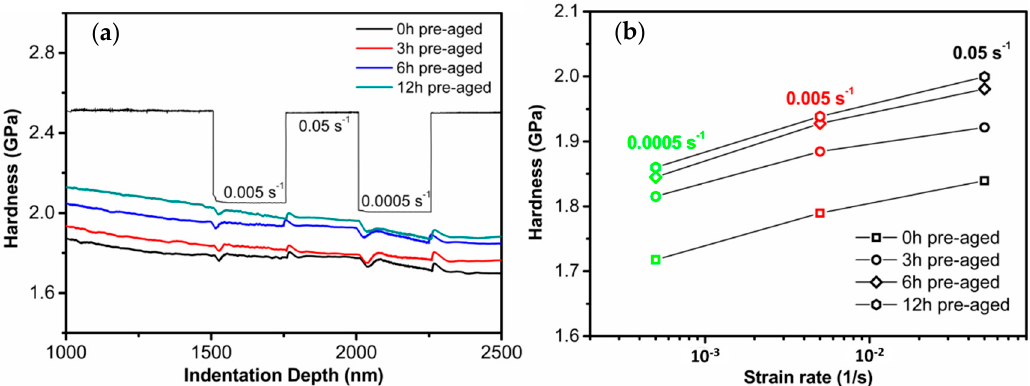
Figure 9. The indentation strain–rate jump experiment of pre-aged AA2524 with three different applied strain rates ( a ) and the correspondent results for hardness ( b ).